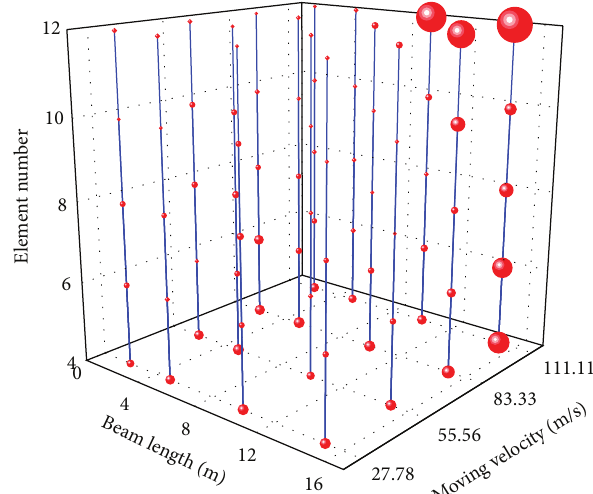
Figure 10: Average relative error of the condensed moving load model (IRS) based on analytical solutions with varying element numbers, beam lengths, and moving